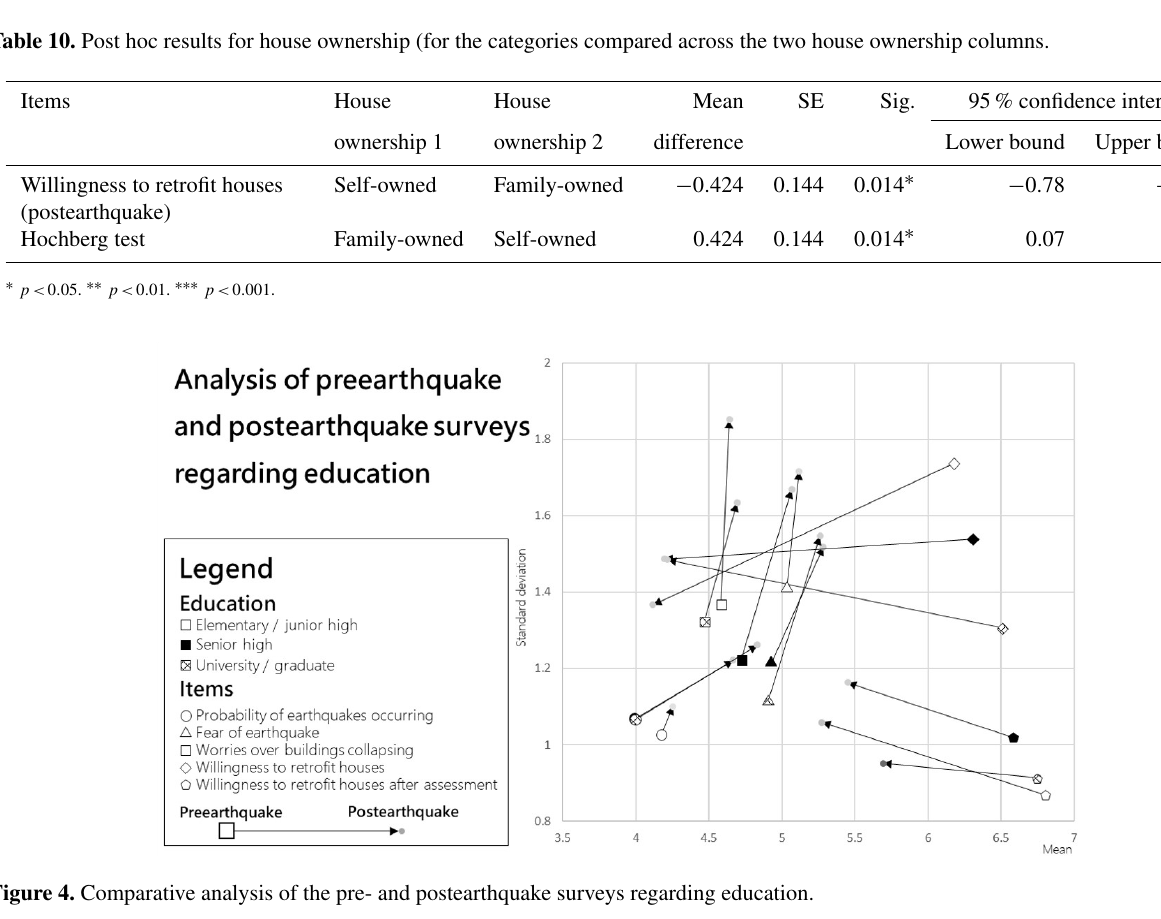
nouncing disaster information, and potential options to re- spond (Fothergill and Peek,